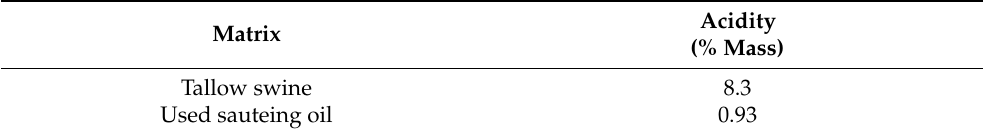
Table 5. Acidity of raw